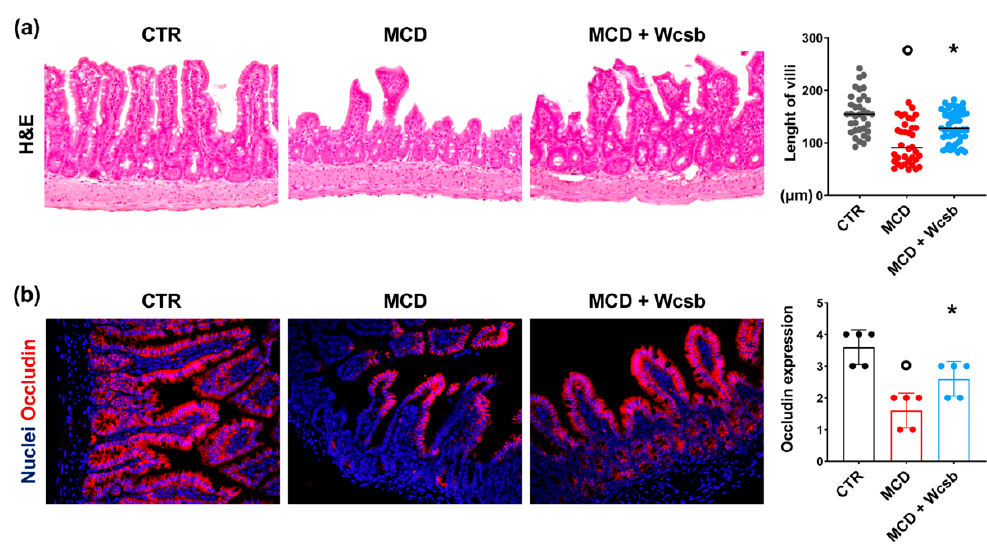
Figure 5. Histopathological and phenotypical modifications in the terminal ileum of mice subjected to a methionine-choline-deficient (MCD) diet and treated with calcium-sulphate-bicarbonate water (W csb ). ( a ) Hematoxylin and eosin (H&E) stain on the ileum of mice after 8 weeks of MCD diet, with or without W csb administration, and in controls (CTR). Villi were shorter in MCD mice compared to CTR; however, W csb administration was associated with longer villi compared to untreated MCD mice. Original magnification: 10×. ( b ) Immunofluorescence for occludin on the ileum of MCD mice with or without W csb administration and in controls. Occludin positivity was lower in MCD mice compared to the CTR but was higher after W csb administration when compared to untreated MCD mice. Original magnification: 20×. In ( a , b ), histograms show means and standard deviations for villi length and occludin positivity score. Data from each animal are plotted as solid circles in the graph. * p < 0.05 vs. all groups; ° p < 0.05 vs. CTR.